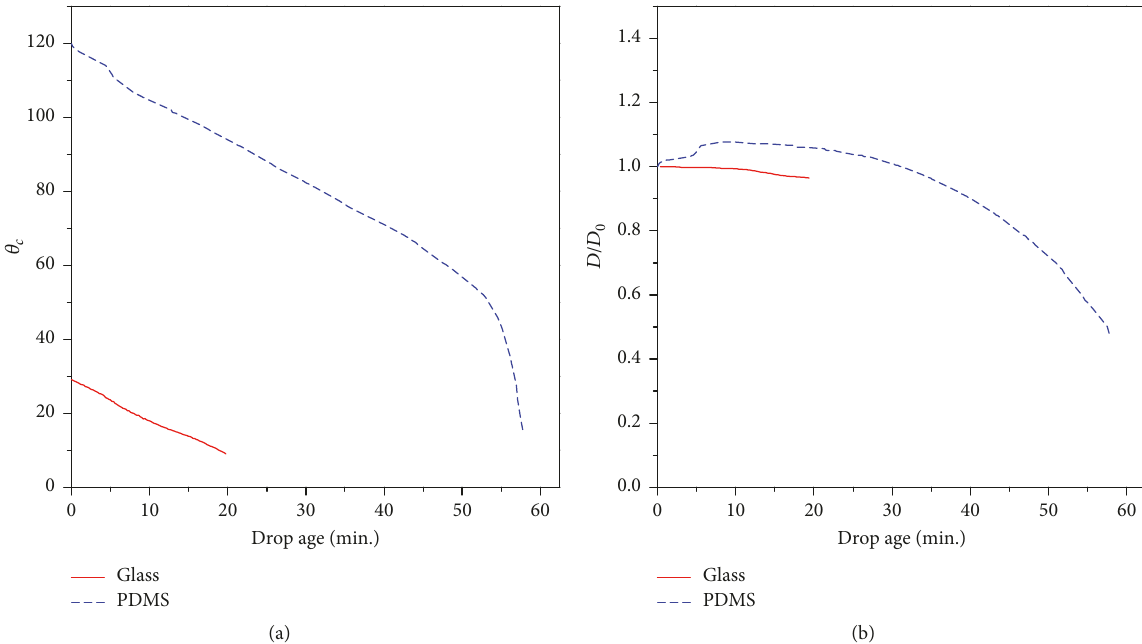
Figure 4: (a) Contact angle variations for a water droplet nontreated glass substrate (red solid curve) and PDMS substrate (blue-dashed curve); (b) normalized diameter of same drops on glass substrate (red solid curve) and PDMS substrate (blue-dashed curve).